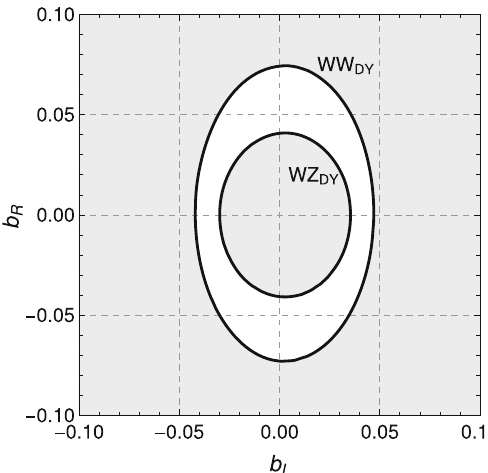
Fig. 11 The excluded region of the ( b L , b R ) -plane (gray area) for the vector resonance with the mass of M = 1 . 8 TeV, g (cid:2)(cid:2) = 18, p = 0 . 8